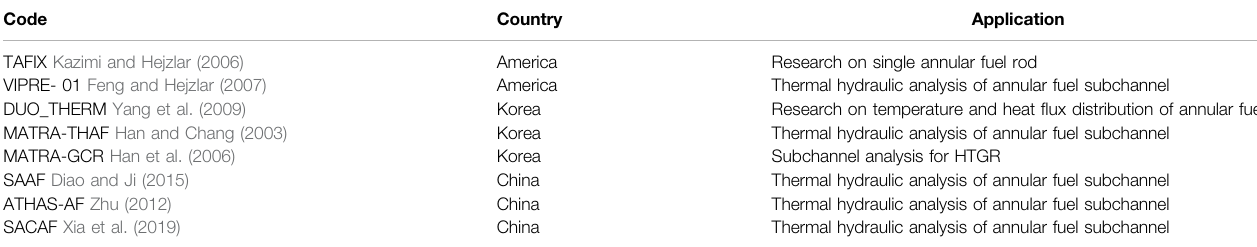
TABLE 1 | Development status of annular fuel analysis codes.